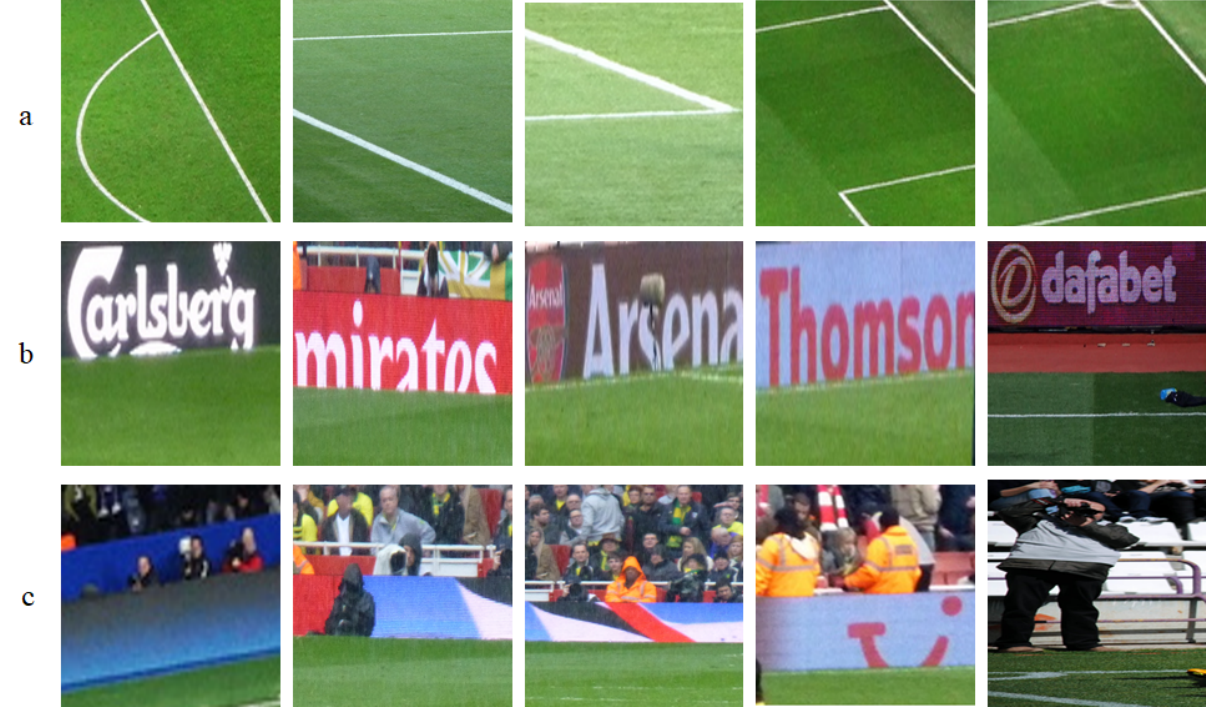
Figure 7. Background-labeled samples from the dataset ( a ) playfield lines, ( b ) advertisements, ( c ) non-playfield